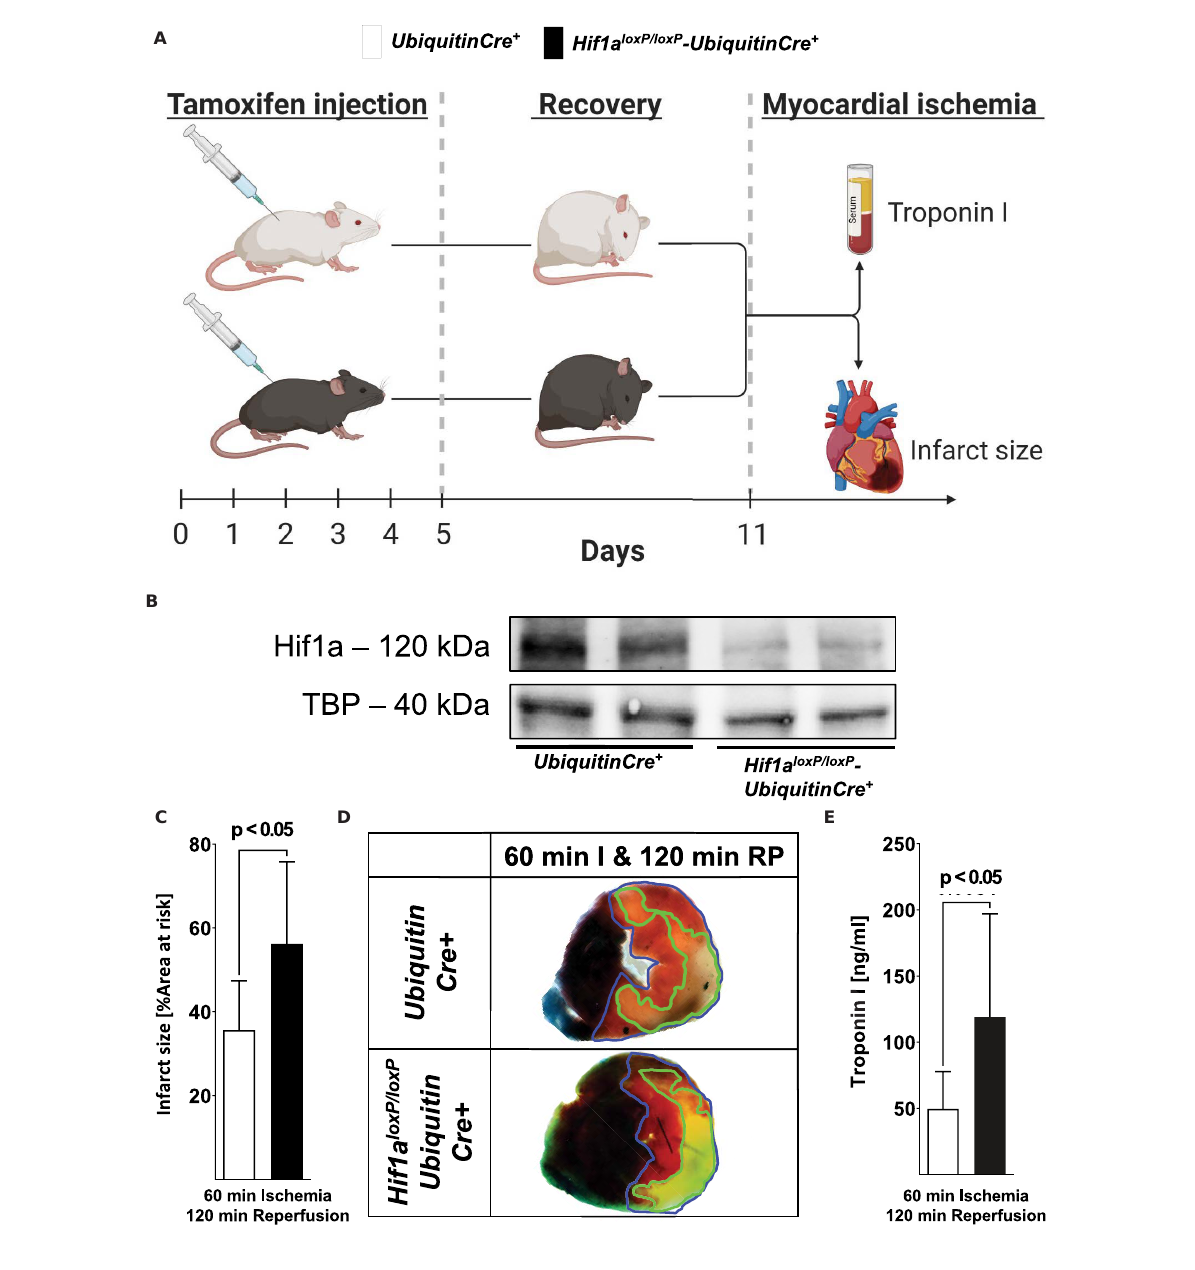
FIGURE1 Functional consequences of the induced global deletion of Hif1a during myocardial ischemia and reperfusion injury. (A) Experimental approach to study global induced Hif1a-deficiency. Hif1a loxP / loxP mice were crossed with Cre-recombinase expressing mice under the control of a ubiquitin promoter (UbiquitinCre+); these mice express cre-recombinase under the control of a tamoxifen inducer. Control animals with sex and weight matched (UbiquitinCre+) or Hif1a loxP / loxP UbiquitinCre+ mice received a daily dose of 1 mg i.p. tamoxifen 5 consecutive days to induce Cre recombinase activity. After 7 days, the animals underwent experimental protocols (60 min of in situ myocardial ischemia followed by 120 min of reperfusion), followed by serum collection to determine the concentrations of troponin I and TCC staining for infarct sizes. (B) Hif1A immunoblot performed on protein isolated from myocardial tissue after treatment with the pharmacological HIF activator dimethyloxalylglycine (1 mg DMOG i.p.) 4 h before tissue collection from UbiquitinCre+ or Hif1a loxP / loxP UbiquitinCre+. A representative image of three individual experiments is presented. (C) The infarct sizes of UbiquitinCre+ or Hif1a loxP / loxP UbiquitinCre+ mice are displayed as a percentage of the area at risk after 60 min of ischemia, followed by 120 min of reperfusion (UbiquitinCre+ n = 7; Hif1a loxP / loxP UbiquitinCre+ n = 5, per group mean ± SD; statistical analysis by two-sided, unpaired Student’s t -test; mice were matched by age, sex, and weight). (D) Representative infarct staining of UbiquitinCre+ or Hif1a loxP / loxP UbiquitinCre+ mice (60 min of ischemia and 120 min of reperfusion). (E) Troponin serum levels after 60 min of ischemia, followed by 120 min of reperfusion in UbiquitinCre+ or Hif1a loxP / loxP UbiquitinCre+ mice (UbiquitinCre+ n = 12; Hif1a loxP / loxP UbiquitinCre+ n = 8 presented as mean ± SD; compared by Student’s t